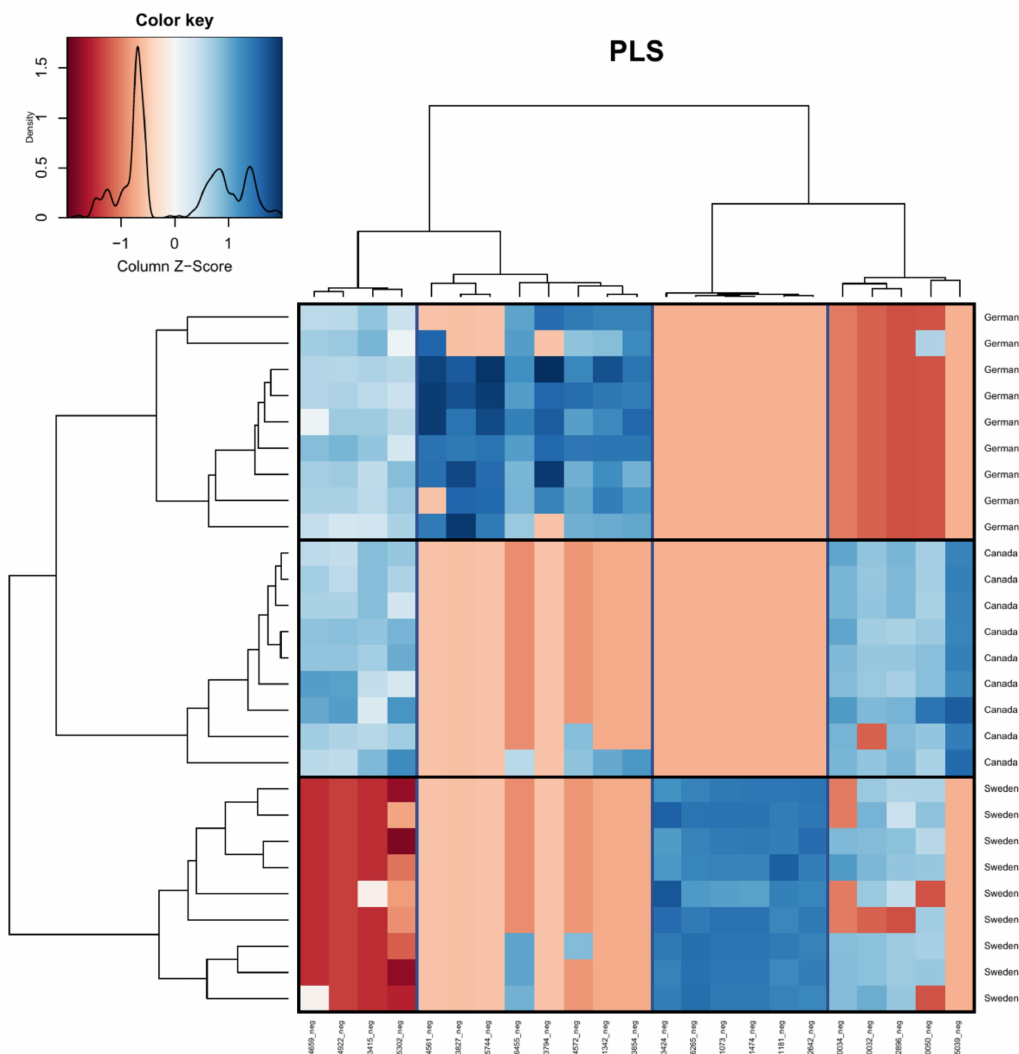
Figure 4. Heatmap visualizing the PLS of the compound table at the level of sample location (country). Boxes have been added for clarity (vertical = feature grouping, horizontal = sample grouping). Red indicates that peak intensities were low, while blue indicates that peak intensities were high. Identification of metabolite features is available in the Supplement (Table